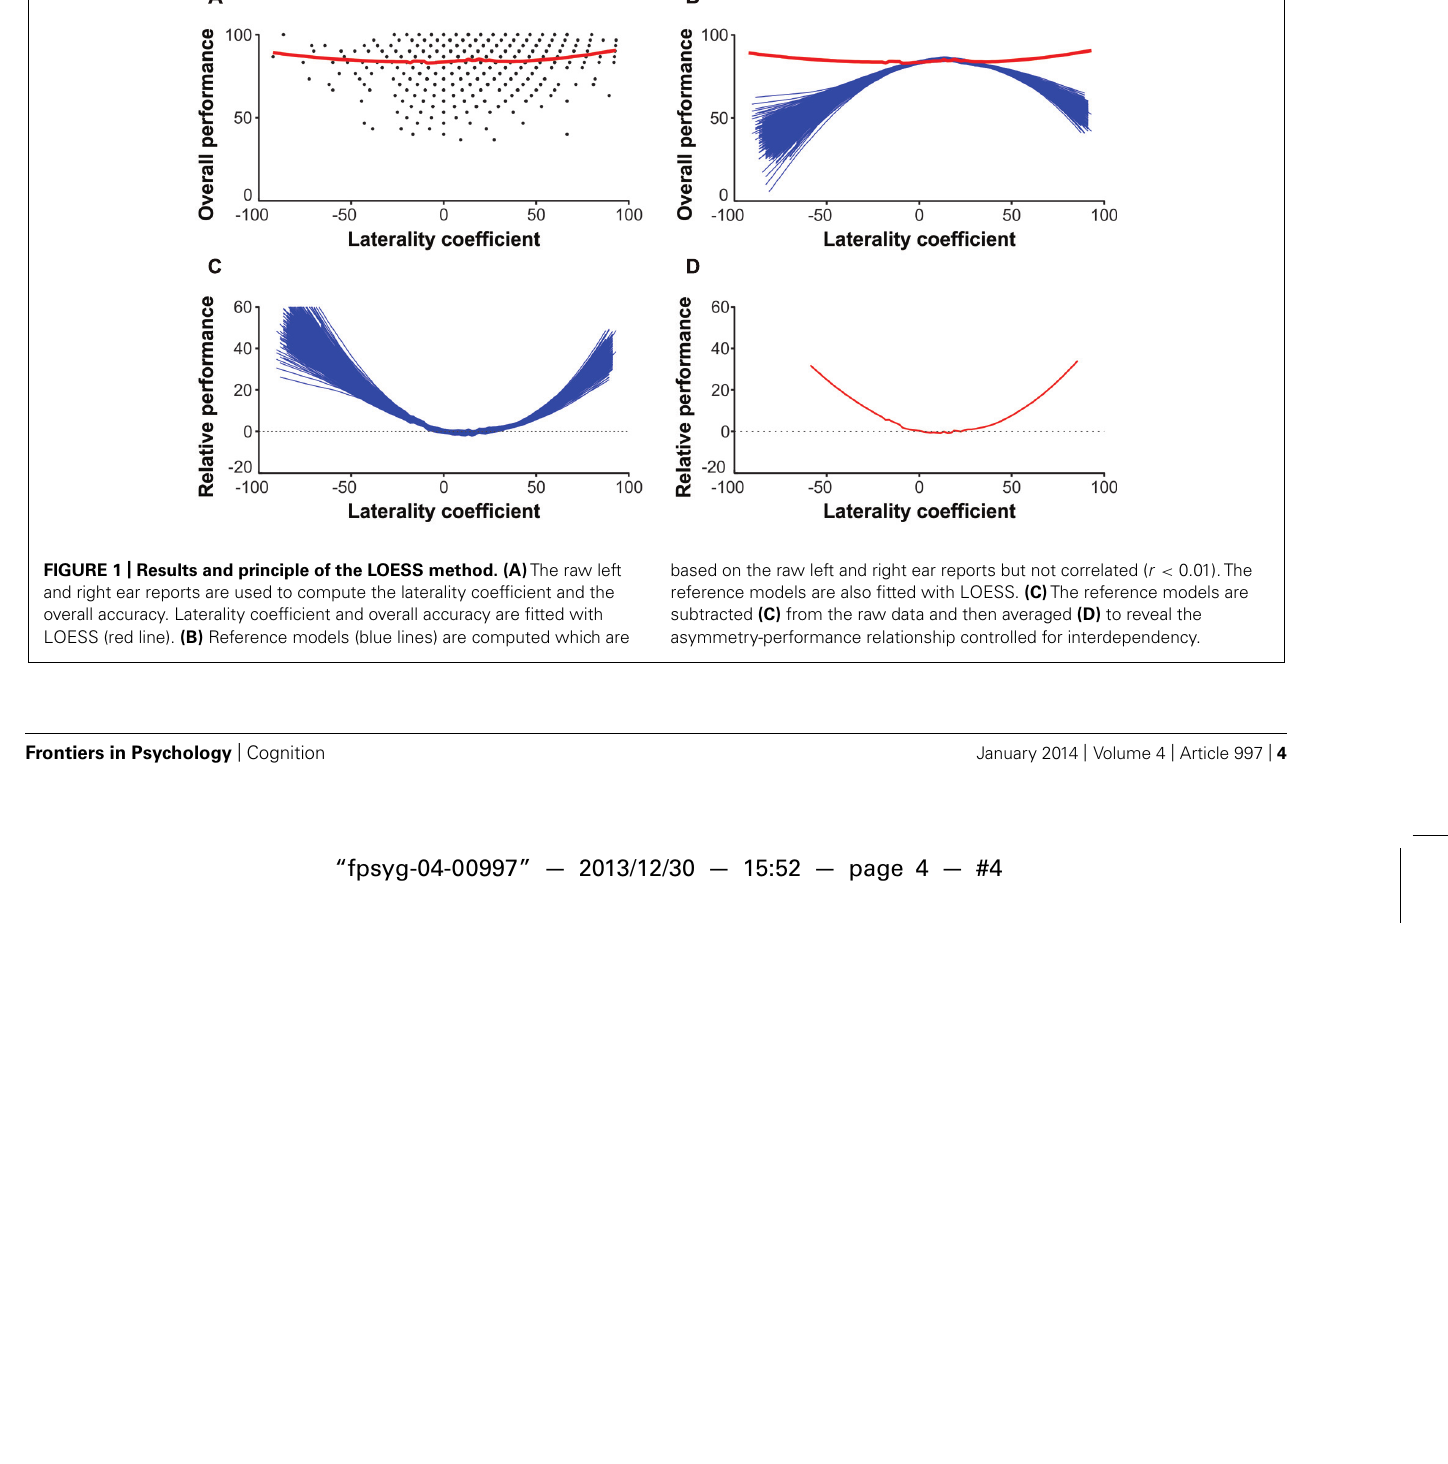
based on the raw left and right ear reports but not correlated ( r < 0.01).The reference models are also fitted with LOESS. (C) The reference models are subtracted (C) from the raw data and then averaged (D) to reveal the asymmetry-performance relationship controlled for